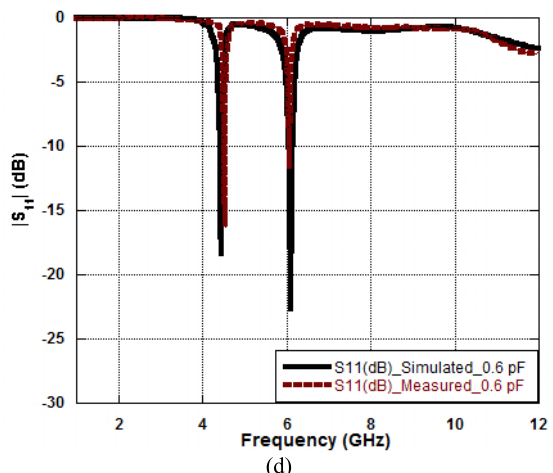
Figure 3: Photos of the prototype and results: (a) Upper view. (b) Bottom view. (c) |S11|. (d) |S11| with and without C = 0.6 pF.